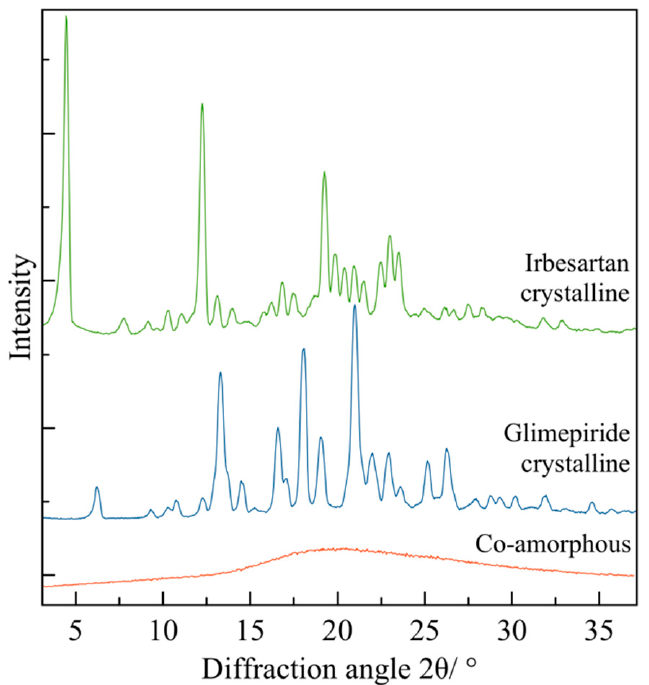
Figure 3. Example of diffractogram of the crystalline pure drug (irbesartan and glimepiride) and co-amorphous form of the binary system.